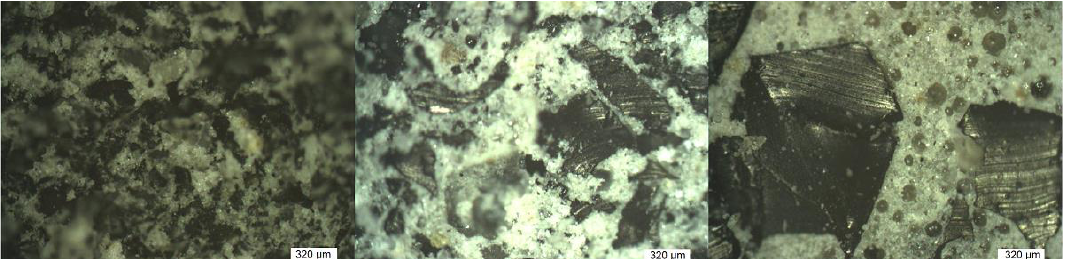
Figure 4. Figures depicting the typical structure of composites in this work created by dark rubber fillers (R 0 , R 1 , and R 2 from left side to the right side, 40 vol.% in all cases, if porosity is neglected), light matrix P 33 -CO 17 -Ca 50 matrix (chosen due to good contrast). The pores are visible in the figure containing R 2 filler and have shapes similar to cubes if they are not in touch with the filler. Figures were observed by optical mode of confocal microscope LEXT OLS 3000.